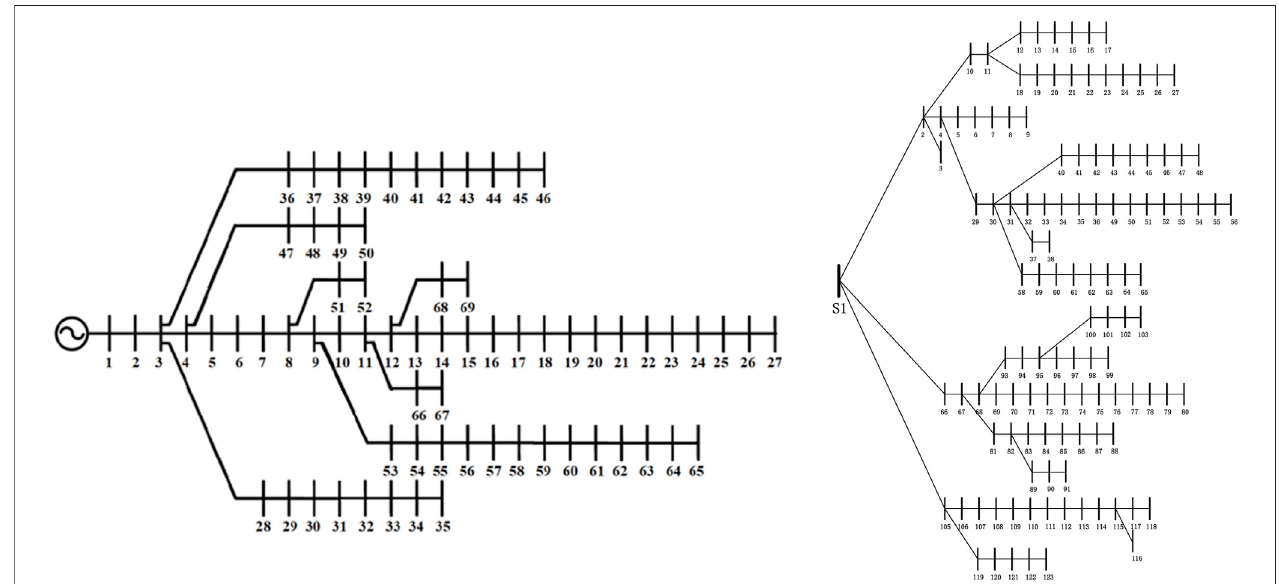
FIGURE 6 | Diagram of the 69 and 119-bus systems.